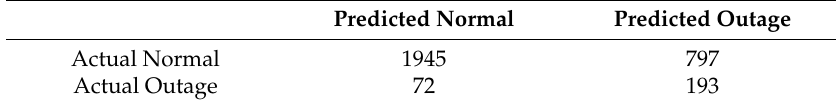
Table 4. Confusion matrix of the proposed SVM model.